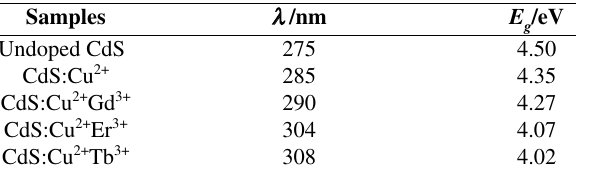
Table 3. Absorption wavelength and calculated